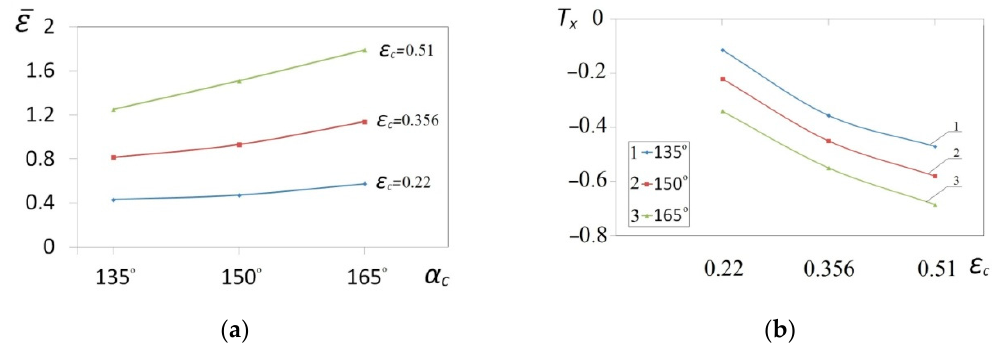
Figure 13. Influence of different angles of convex anvils α c and reduction ratio ε c on the effective strain ε ( a ) and the stress triaxiality ratio T x ( b ) in the axial zone.